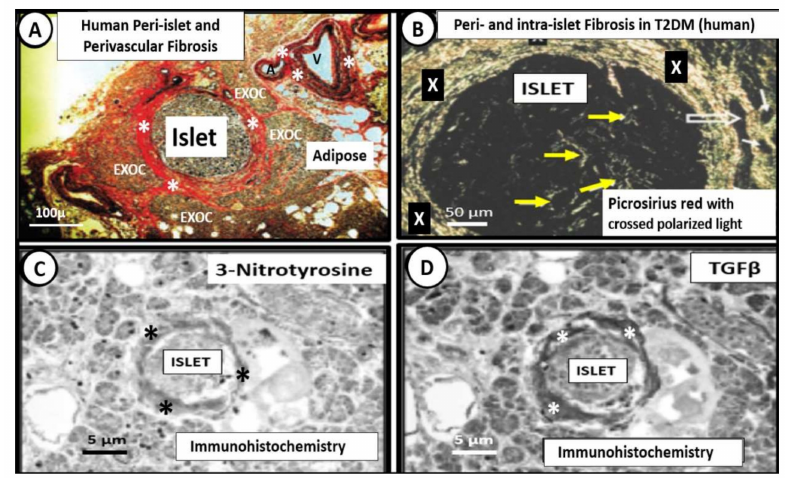
Figure 8. Human intra-islet, peri-islet and perivascular fibrosis. (Panels ( A , B )) depict peri- and intra-islet fibrosis and perivascular fibrosis in a female human (age 58) with T2DM of 6 years duration who was insulin dependent for one year at time of death from an acute myocardial infarction. (Panel ( A )) depicts marked peri-islet, and perivascular fibrosis in the pancreas and thus is capable of interfering with communication between the islet endocrine and exocrine pancreas with Verhoe ff Van Gieson (VVG) staining for fibrosis (crimson-red) (asterisks) and elastin (black). Note perivascular fibrosis surrounding an arteriole (A) and venule (V) (asterisks). (Panel ( B )) demonstrates marked peri-islet fibrosis (X) and intra-islet fibrosis (yellow arrows). Note that the open arrows depict the islet–acinar–portal vascular pathway (venule) utilizing picrosirius red staining with crossed polarized light. (Panels ( C , D )) represent the immunohistochemistry staining for 3-nitrotyrosine (reflecting oxidative nitrosative stress) and TGF β (profibrotic cytokine-growth factor), respectively. Images A–D modified via courtesy of [48,52]. EXOC = exocrine